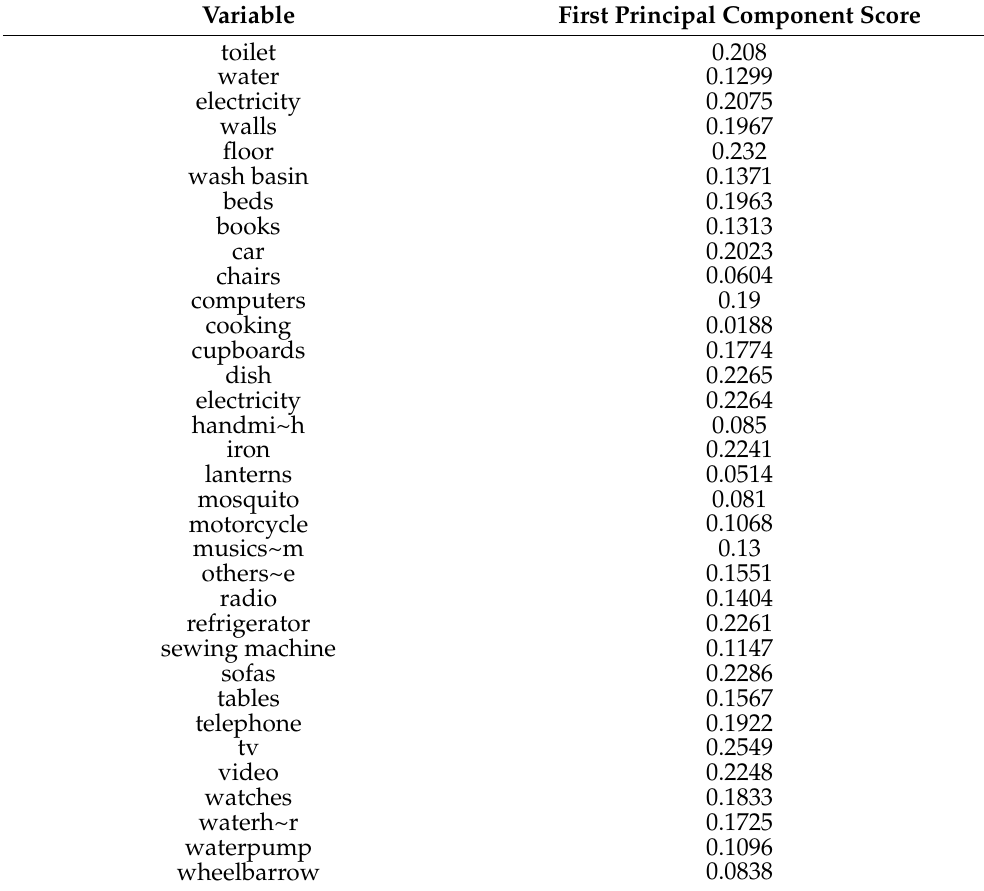
Table A5. Asset index for Tanzania—Results from Tetrachoric Principal Components